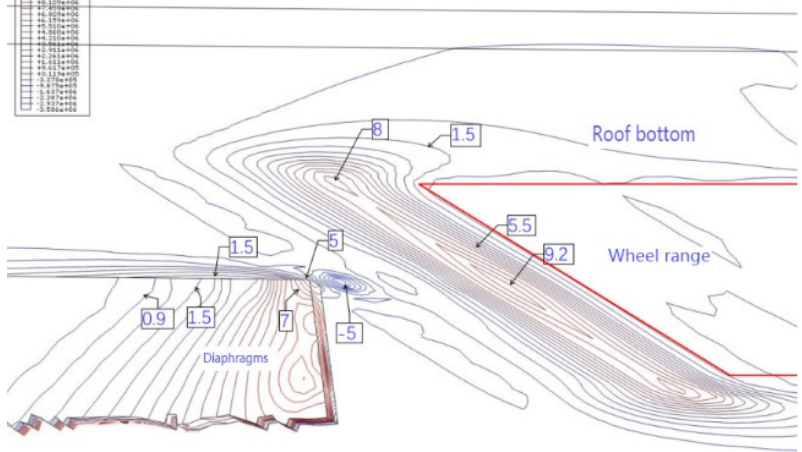
Figure 12. Isoline of 3-D principal stress at the joint of roof, U-rib, and diaphragm (U-rib not shown) (MPa).